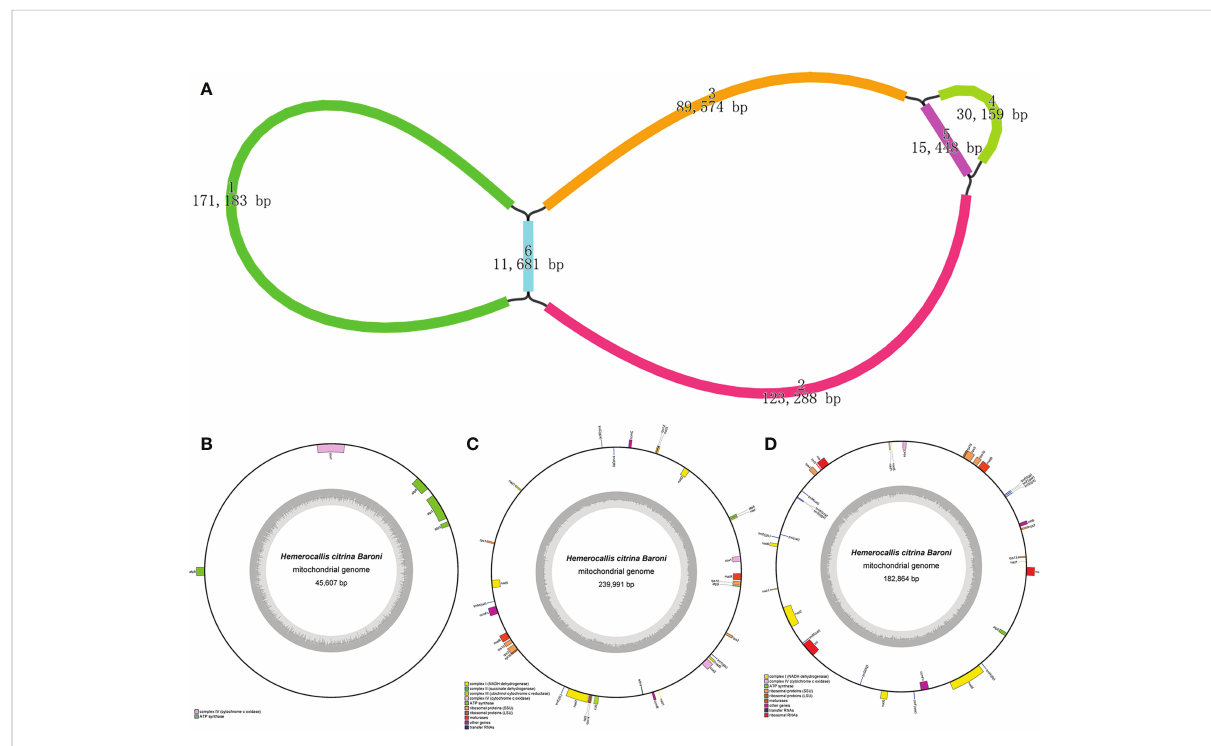
FIGURE 1 Assembly results of the H. citrina mitogenome. (A) The assembly graph of the H. citrina mitogenome. Each colored segment is labeled with its size and named 1-6 by rank of size. (B-D) Circular map of the H. citrina mitogenome. Genes presented on the outer circle are transcribed, whereas genes on the inside are counterclockwise. The inner circle reveals the GC content as a dark gray plot with the gray line in the middle as the 50% threshold line. (B) Schematic diagram of molecule 1 with a length of 45,607 bp and fi ve annotated genes; (C, D) Similar maps for molecule 2 and molecule 3 with lengths of 239,991 bp and 182,864 bp, respectively. Because the three genes ( nad1, nad2 , and nad5 ) encoding the subunits of Complex I (NADH dehydrogenase) are fragmented in molecules 2 and 3, the two mt circular molecules encode a total of 61